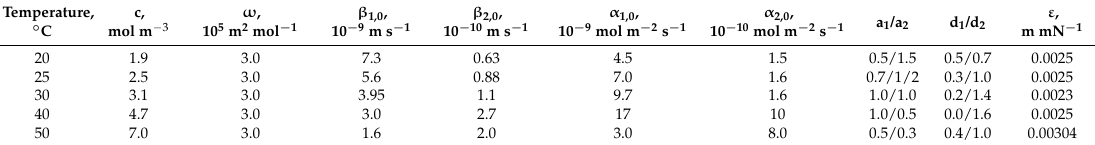
Table 1. Model parameters of heptane adsorption at different temperatures. Note, instead of four model parameters ϕ a,i and ϕ d,i , (i = 1, 2), the parameters a i = ( ϕ d,i − ϕ a,i ) /2 and d i = ( ϕ d,i + ϕ a,i ) /2 are used in the calculations.